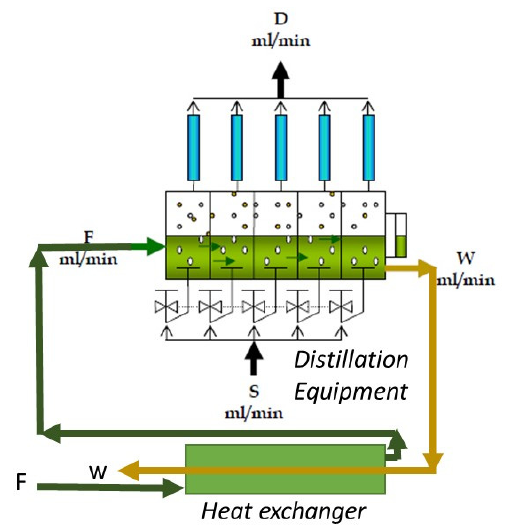
Figure 3. Schematic figure of distillation.